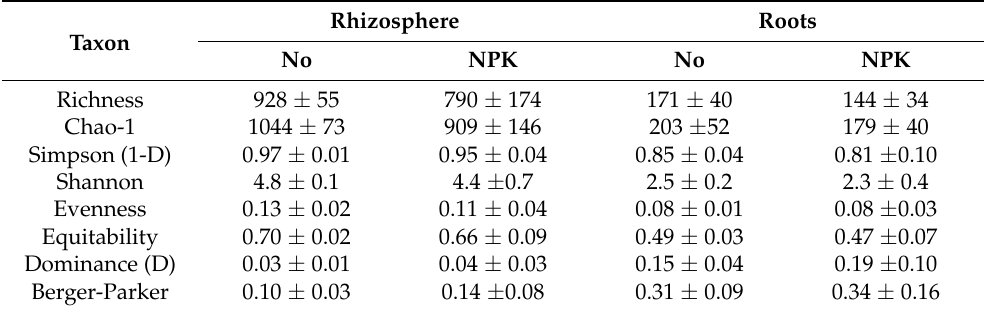
Table 6. Alpha-biodiversity indices (mean ± standard deviation) of the mycobiome in the tomato roots grown under different fertilization on Phaeozem in the open field in the south of West Siberia. Rhizosphere Roots Taxon No NPK No NPK Richness